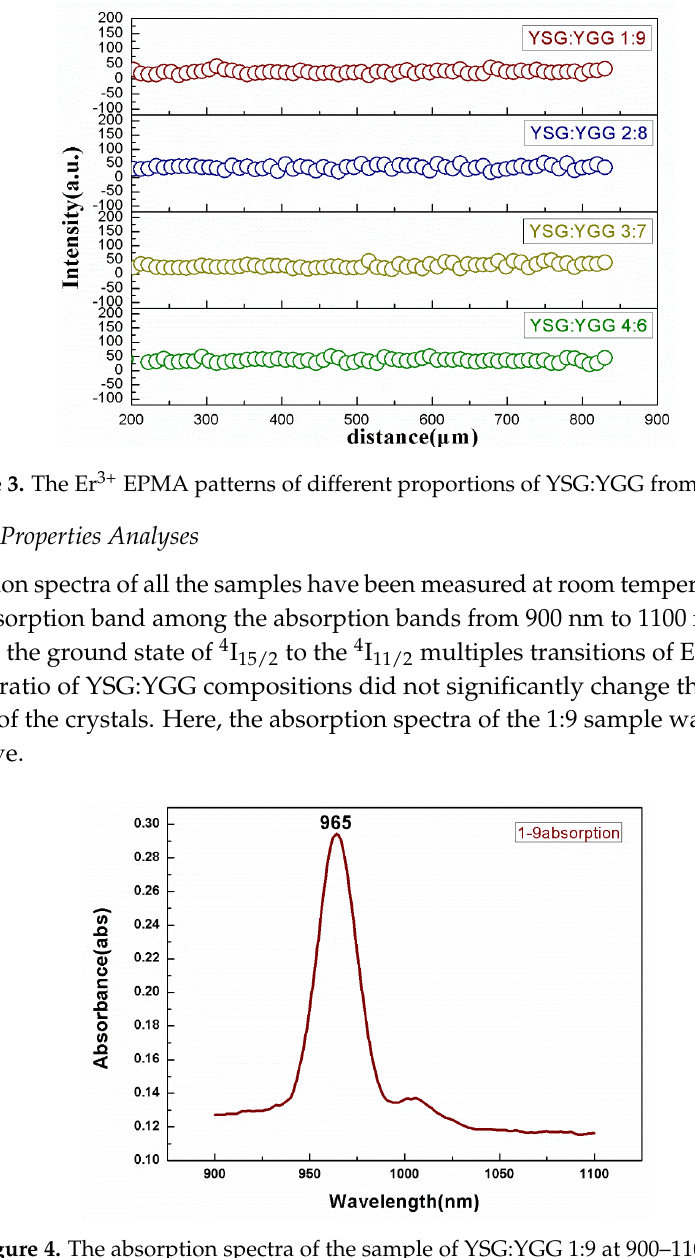
Figure 4. The absorption spectra of the sample of YSG:YGG 1:9 at 900–1100 nm.